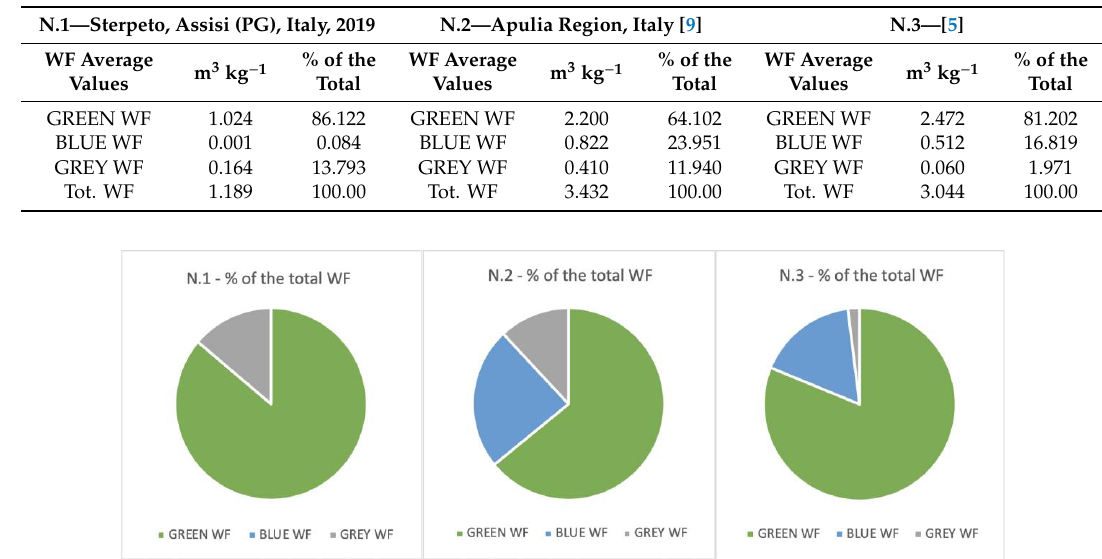
Table 3. WF average values comparison between this case study, Apulia and standard world value.